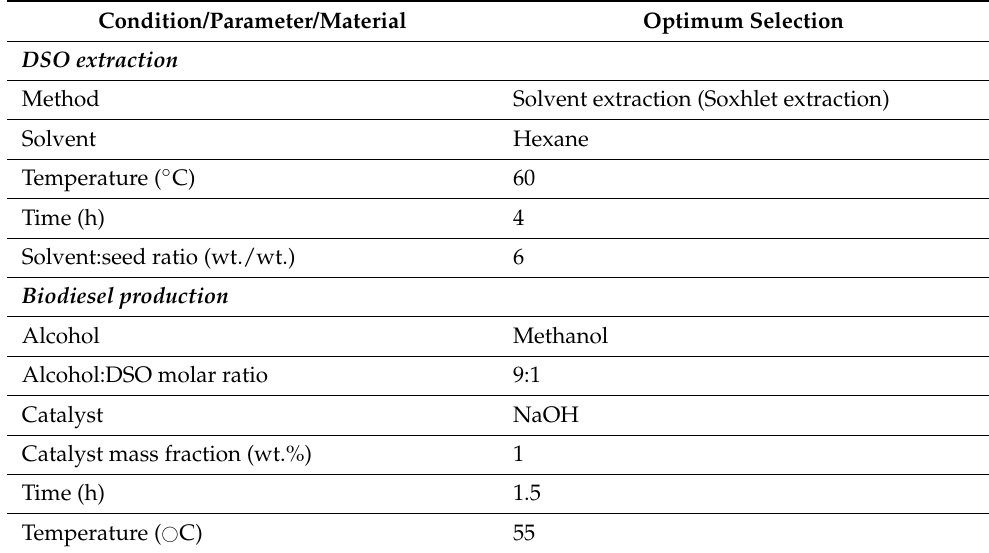
Table 1. Optimum conditions for DSO extraction and DSO biodiesel